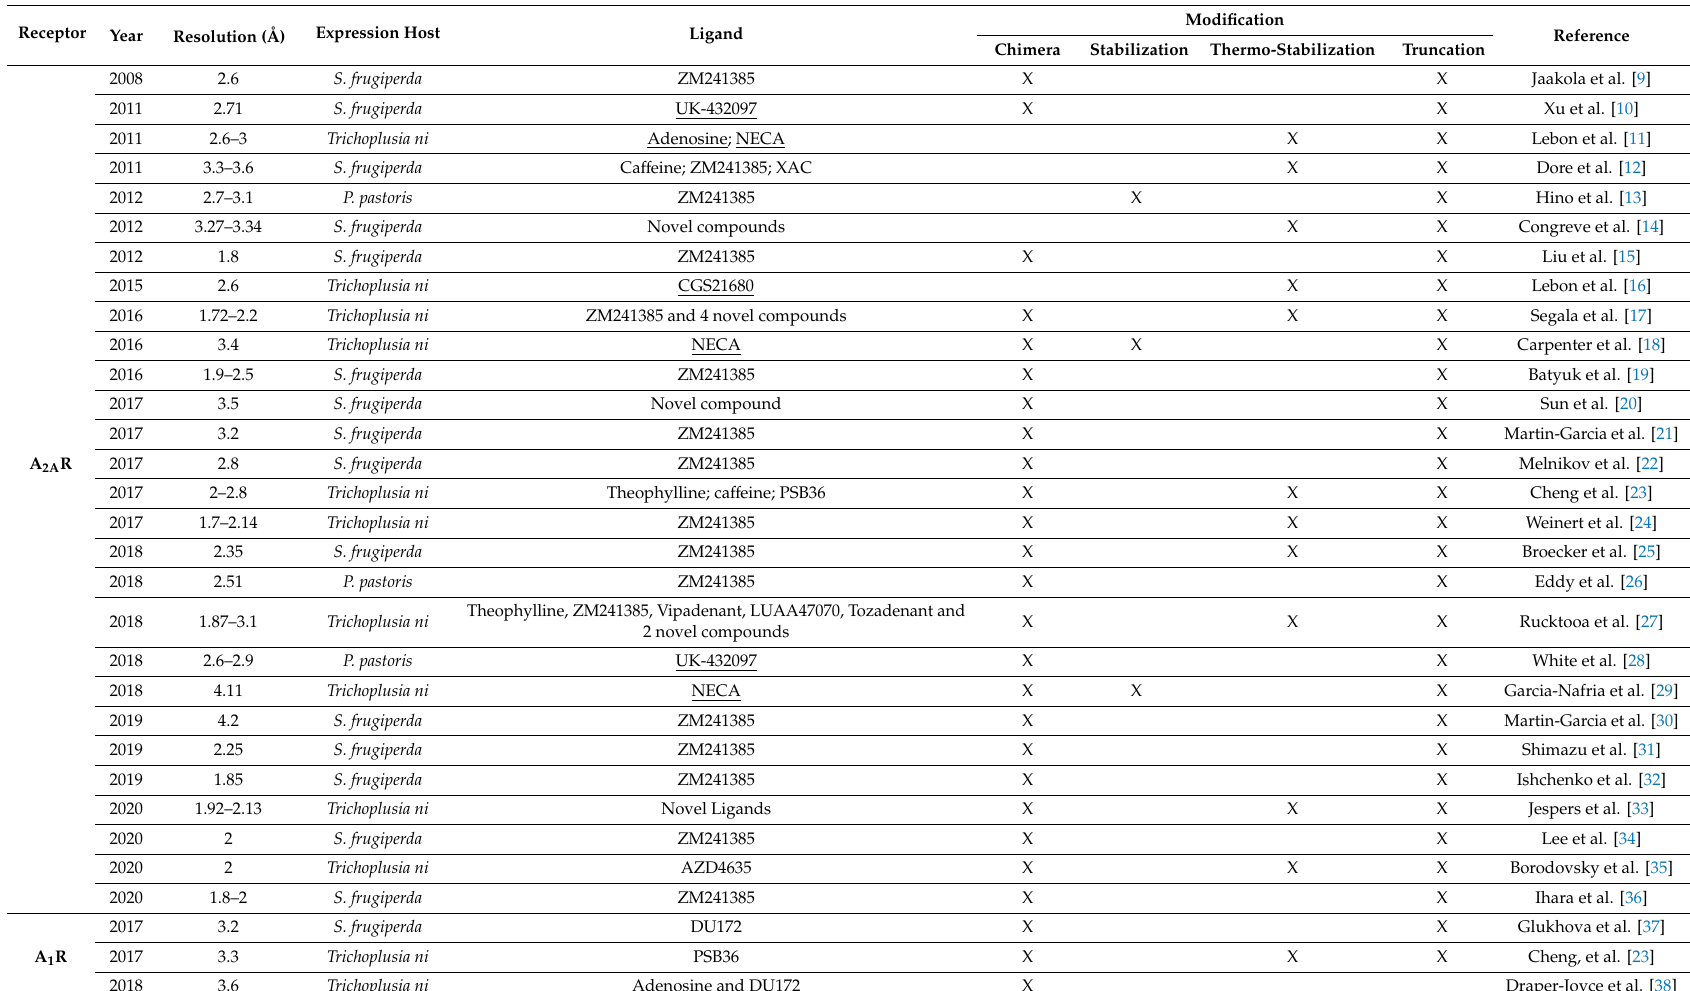
Table 1. List of adenosine receptor high-resolution structures. Agonists are